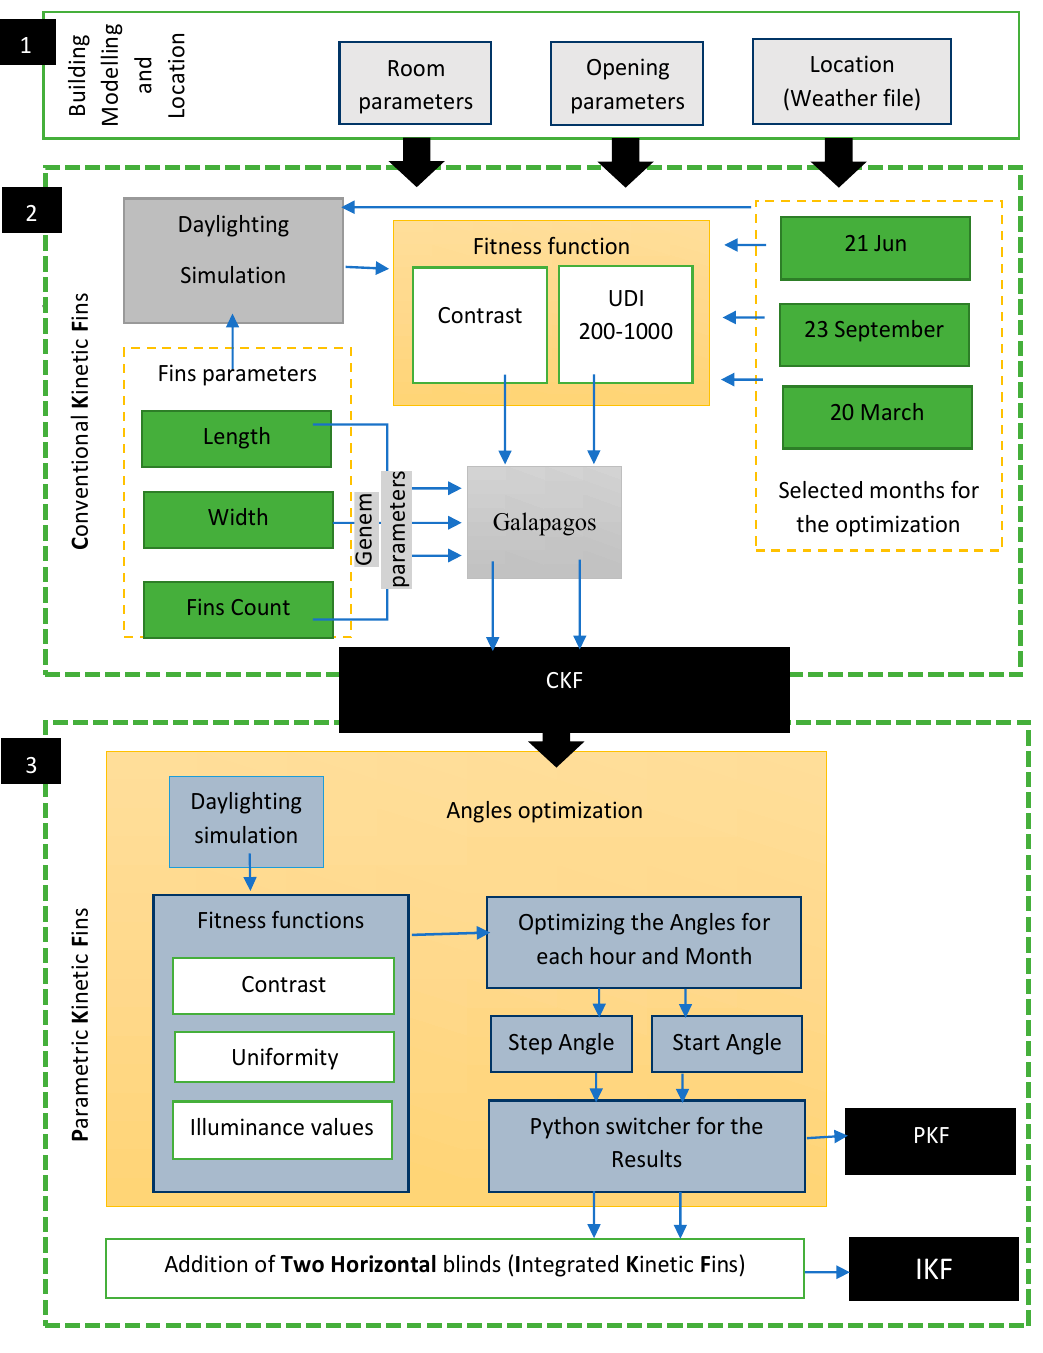
Figure 4. The framework for the proposed system.